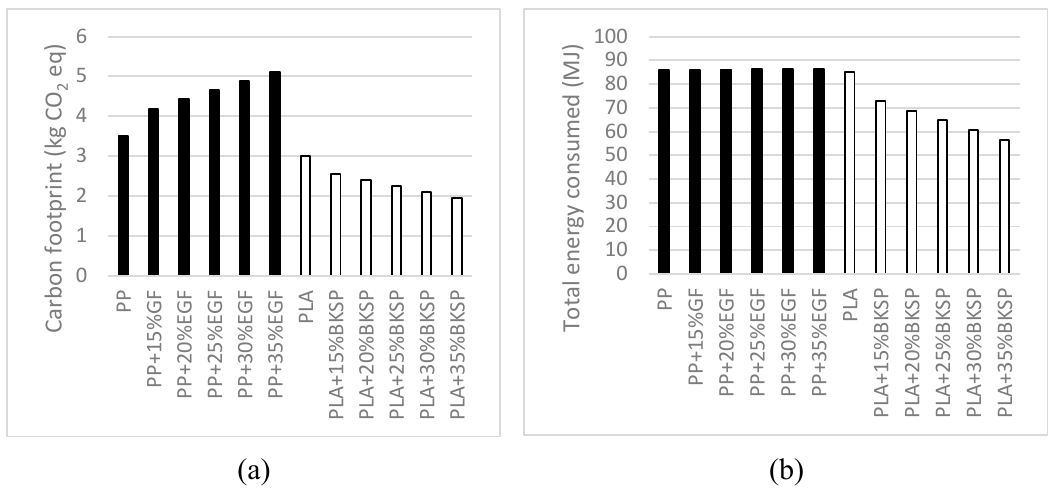
Figure 10. Environmental impact of GF-reinforced PP and SGW-reinforced PLA composites per kg of material production; ( a ): carbon footprint, ( b ): total energy consumed.